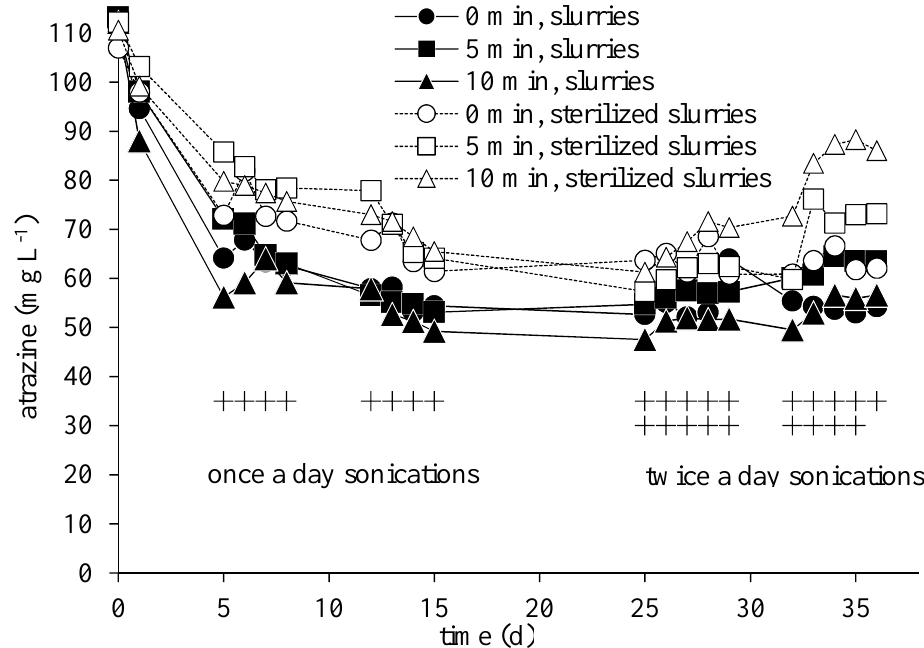
Figure 1. Atrazine concentrations ( n = 3) in the slurries and sterilized slurries, all sonicated for 0, 5, or 10 min. One or two sonication times per day are marked with +. The average of standard deviations was 4.9 ± 3.0 mg · L − 1